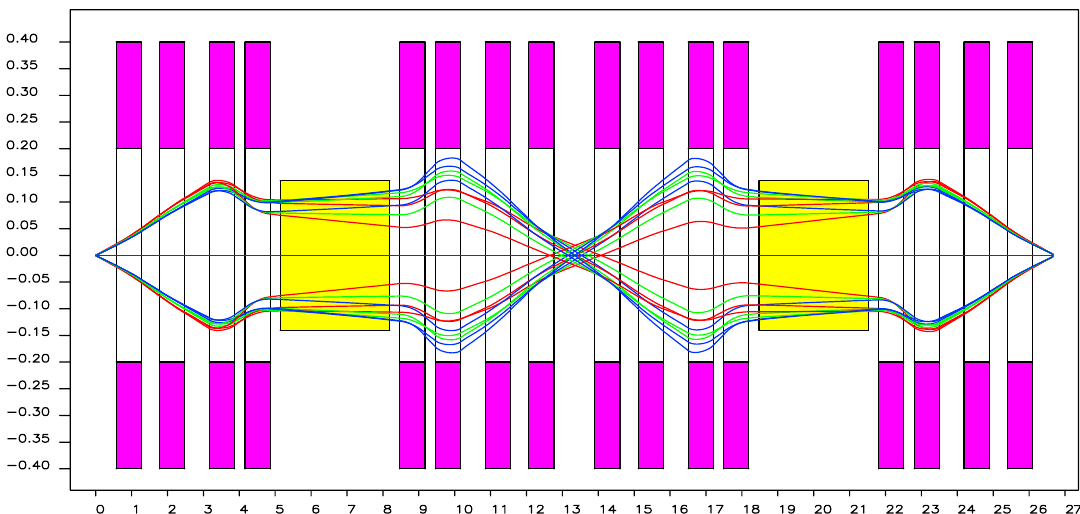
FIG. 4. (Color) Third order vertical envelope corresponding to acceptance (initial beam emittance of (cid:10) 1 mm , (cid:10) 40 mrad horizontally and (cid:10) 50 mrad vertically, and (cid:10) 10% energy